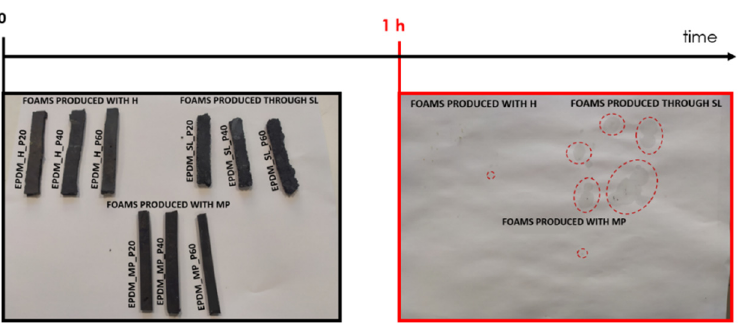
Figure 2. Results of the leakage tests at 90 °C on the prepared paraffin-filled foams. Rectangular specimens were place on a sheet of paper and maintained for 1 h at 90 °C. After the set time, the specimens were removed and eventual leakage of paraffin was investigated.